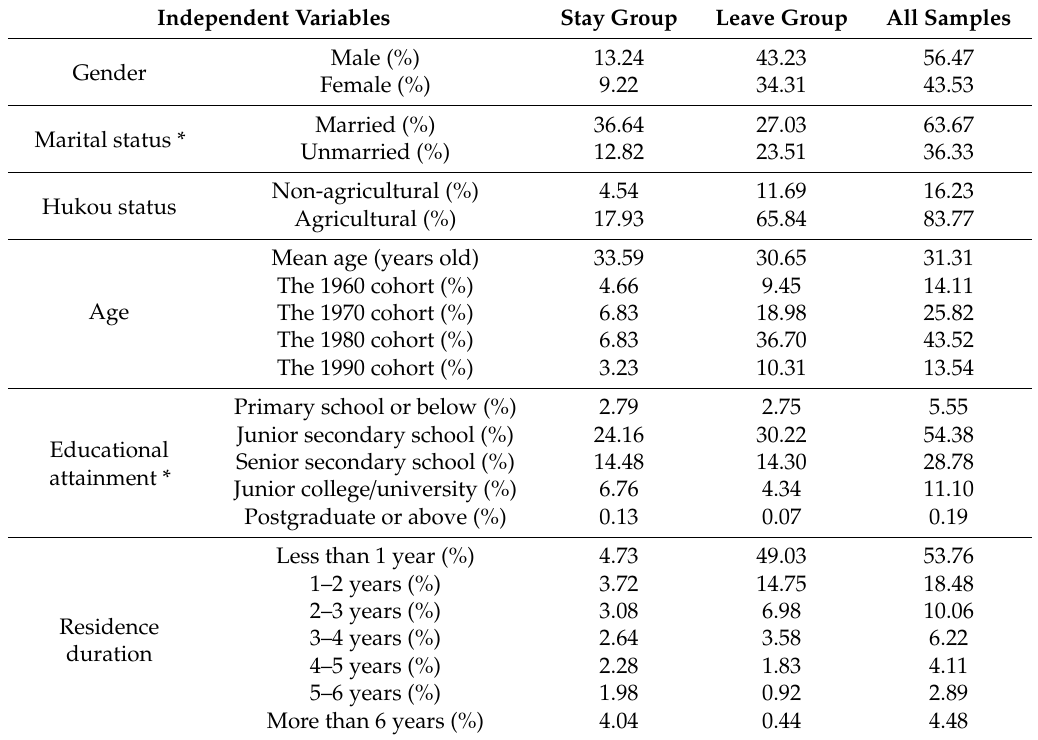
Table 3. Descriptive statistics of independent variables in two